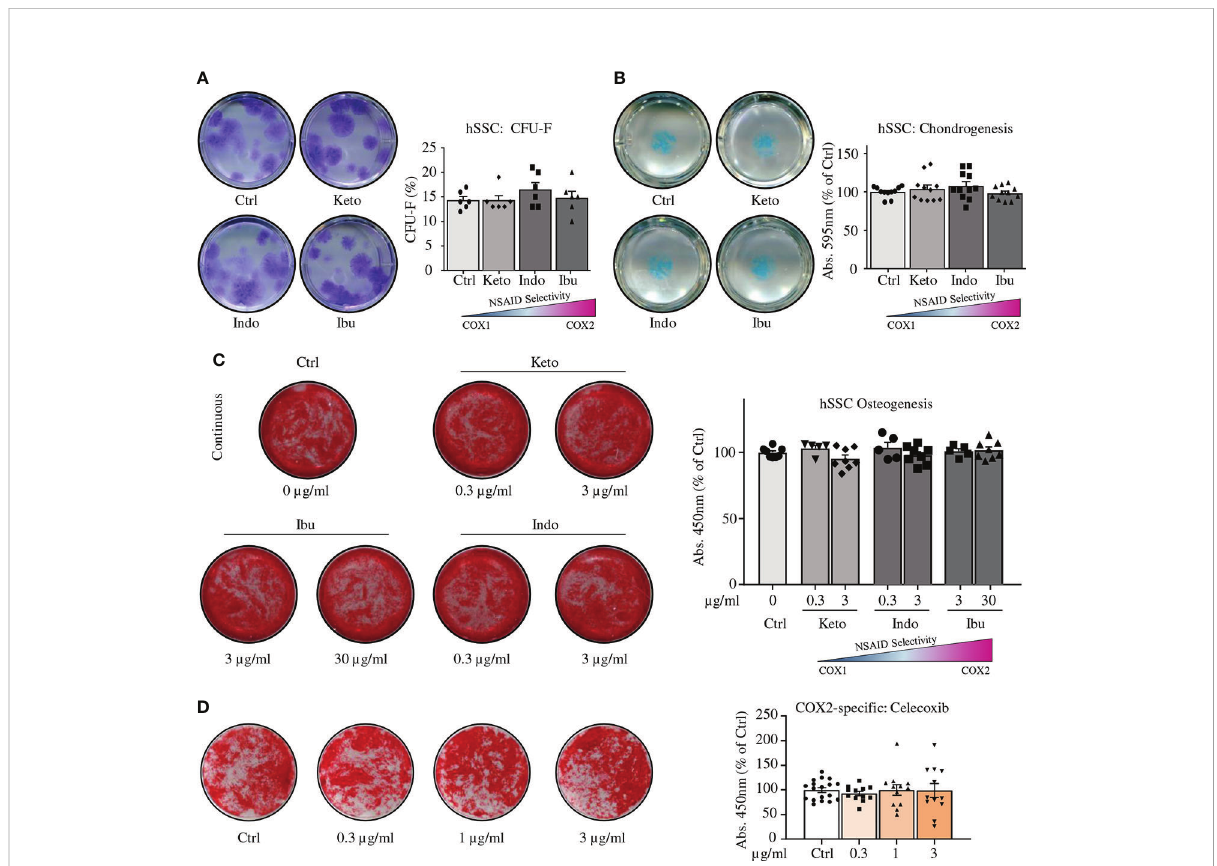
FIGURE 3 NSAIDs do not alter in vitro functionality of human SSCs. (A) Representative images of CFU-F assays offracture derived hSSCs stained with Crystal Violet expanded in the absence or presence of NSAIDs (left; Ketorolac 3 µg/ml, Ibuprofen 30 µg/ml, or Indomethacin 3 µg/ml) and quanti fi cation thereof (right). n=6 independent replicates from hSSCs of two patients performed in triplicate. (B) Representative images of chondrogenesis assays offracture derived hSSCs stained with Alican Blue differentiated in the absence or presence of NSAIDs (left) and quanti fi cation thereof (right). n=11 independent replicates from hSSCs of fi ve patients performed at least in duplicate. (C) Continuous NSAID treatment of osteogenic differentiation assays from hSSCs. n=8 independent replicates from hSSCs offour patients performed in duplicate. (D) Osteogenic differentiation of hSSCs in the presence of COX2- speci fi c inhibitor Celecoxib. n=12-18 independent replicates from hSSCs of six patients performed at least in duplicates. All data shown as mean ± standard error of mean (SEM). All results from at least two independent experiments. Statistical testing versus control group by unpaired Student ’ s t-test with Welch ’ s correction for unequal variances where